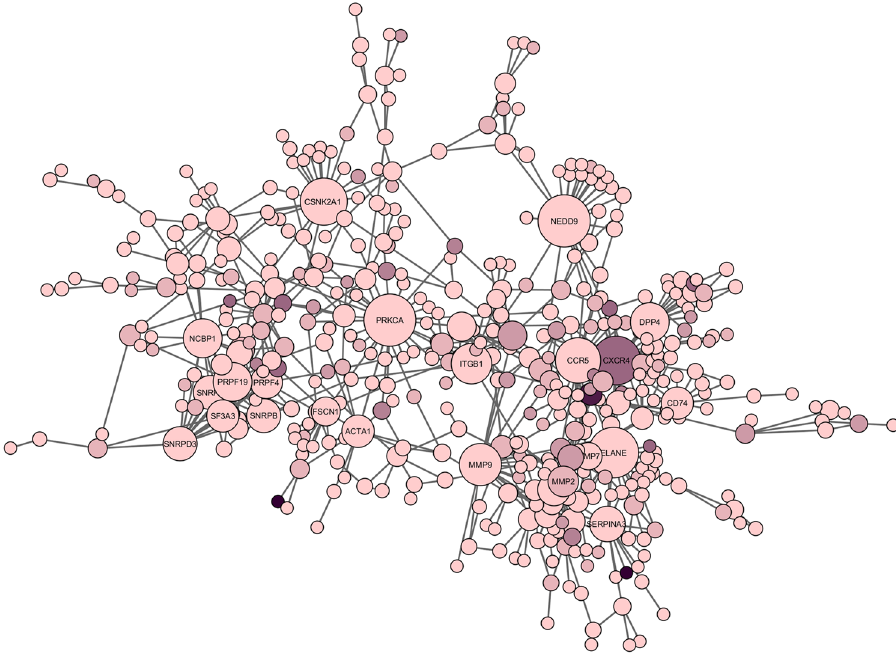
Figure 6. Merged structural network. Node size shows the node degree. Node colour corresponds to the number of alternative conformations, i.e. the darker the node colour is, the more alternative conformation it